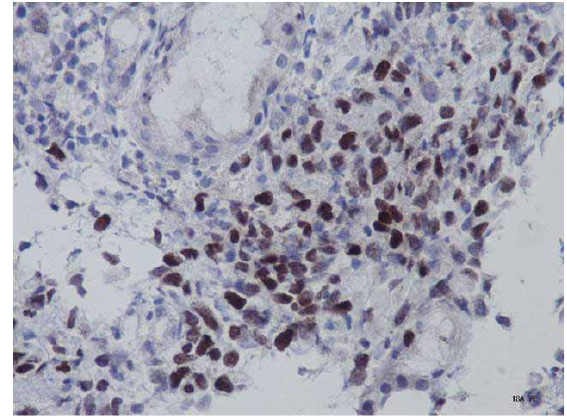
Figure 6. Metastatic cells (primary lung adenocarcinoma) stained with TTF-1 (immunohistochemistry)